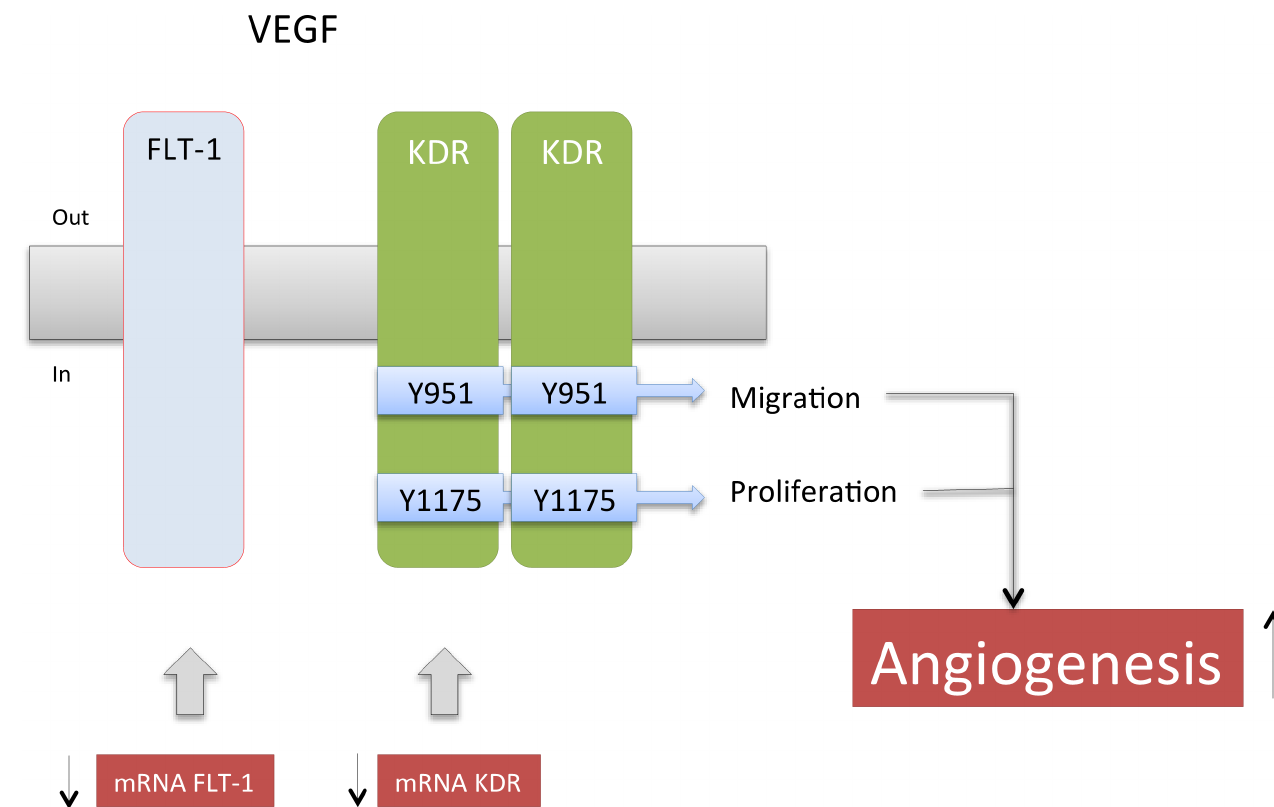
Fig 8. Working model. Results of this study suggest that placentasfrom gestational diabetes mellitus are in a proangiogenic state characterized by elevatedendothelialcell markers, ie. more endothelialcells, and higherKDR, resultingin enhanced migration in GDM cells than cells from normal control pregnancies.Additionalalteration/compensatorymechanisms includereduction in the mRNA and protein levels of Flt-1, reduced mRNA levels of KDR, and no changesin VEGF, or cell proliferation. Changesobservedin GDM are shown in red and black arrows.